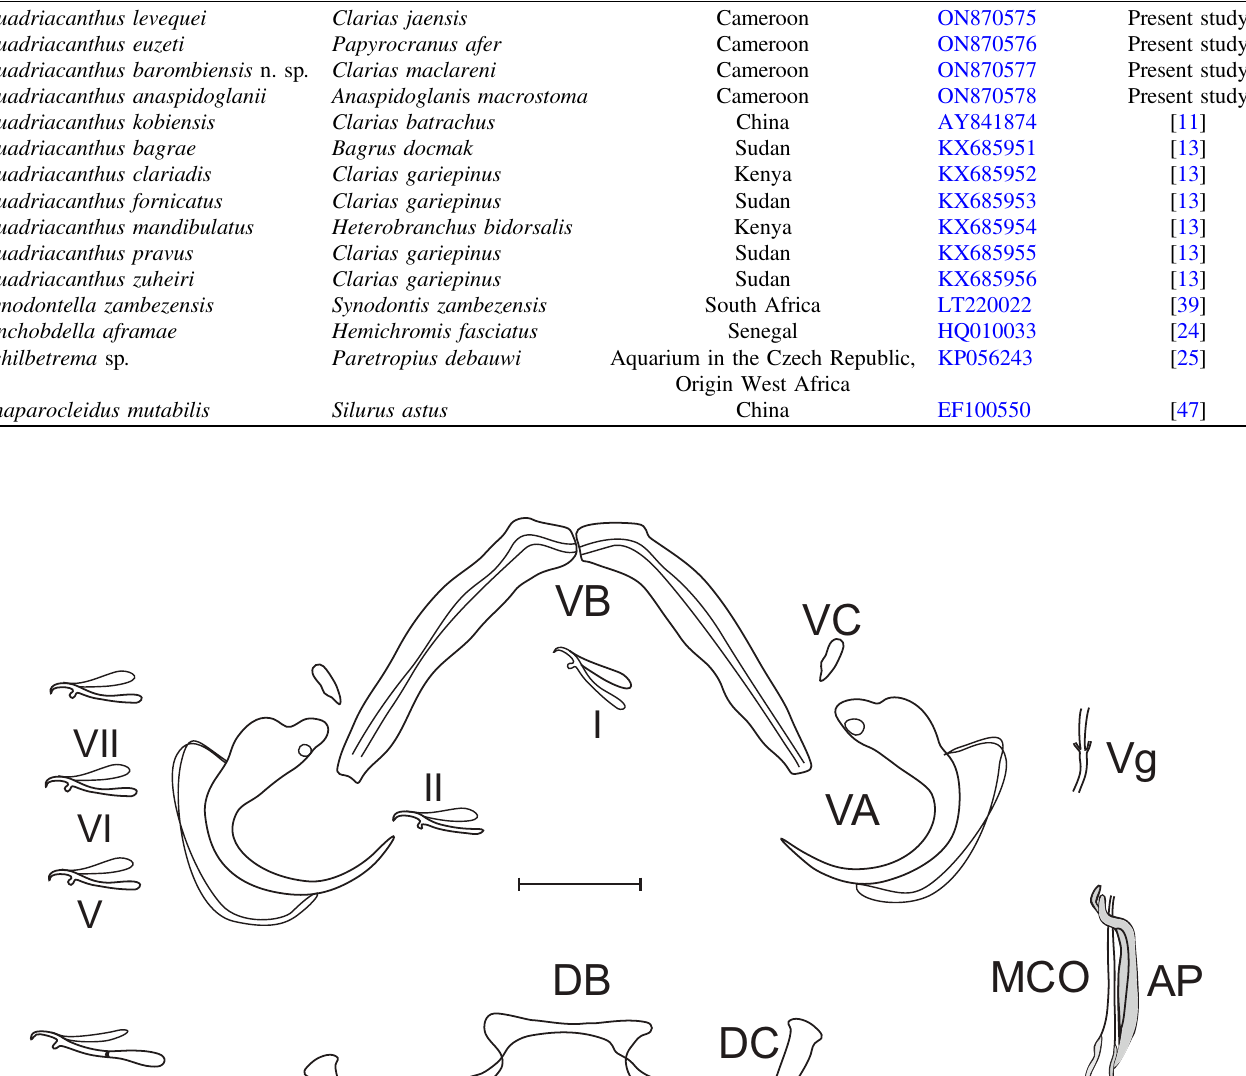
nor handle, but with regular curved blade ending with a short point. Dorsal cunei elongated. Ventral bar V-shaped made up of two medially articulated branches. Ventral anchors with shaft and handle slightly differentiated, curved blade ending with long point. Ventral cunei triangular, smaller than dorsal ones.